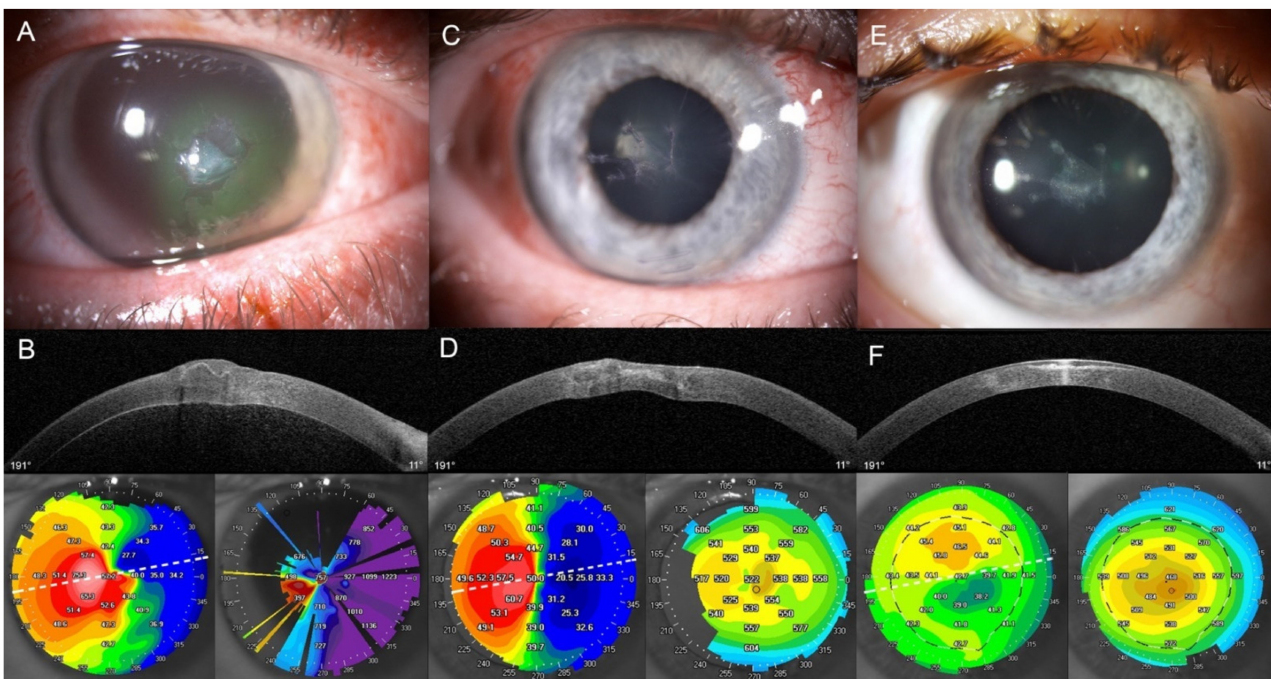
Figure 2. Disorganized central laceration in stromal mush, caused by high-speed projectile (stone) while riding a motorcycle, on a 43-year-old man. Multimodal imaging of the corneal wound. [( A , C , E ): Slit lamp images (Topcon). ( B , D , F ): Anterior segment OCT (AS-OCT), topography and pachymetry map (SS-OCT CASIA 2, Tomey) images]. ( A , B ) Baseline examination showing a central wound of 2.75 mm in diameter in zone 1 (OTC group), with epithelial defect, stromal edema and loss of transparency due to a mush under the retracted Bowman’s membrane (BM) with inferonasal hinge. A second laceration was close to the inferior limbus. Anterior chamber was normal. B-scan showed the disorganized anterior stroma with the BM flap (waved hyperreflective line). There were 12.2 diopters of corneal astigmatism, with major artifacts (suboptimal segmentations not improvable of software) on topography (white dashed line indicates B-scan axis) and pachymetry maps. Maximum lamellar depth was 47% of total corneal thickness. Preoperative far visual acuity (VA) was 20/2000 (2.0 logarithm of the minimal angle resolution (logMAR)). ( C , D ) Postoperative result at Day 10, showing four central light-purple threads of polyglactin 910 (or V10-0) which spared the visual axis and stretched the BM flap, and three peripheral V10-0 threads which treated spiroid paralimbic scalp. There was a very significant improvement of central corneal transparency. B-scan showed progressive reorganization of the anterior stroma with a BM flap flattened thanks to suture-induced tension. Artifacts were reduced on topography with transient suture-induced astigmatism. Initial post-traumatic stromal mush reduced central corneal thickness. ( E , F ) Mid-term result at Month 2, the wound healed with a mild central opacity corresponding to the interface of wounded BM. No more threads were present. A mild loss of transparency was visible at the entry and exit points of the threads path. Comparative B-scan showed longitudinal anterior stromal hyperreflectivity corresponding to the wounded BM, which was flattened thanks to surgery, but thickened with reorganized keratocytes. Residual astigmatism was 1.9 diopters. Pachymetry map was homogeneous and central corneal thickness was reduced in the area of the initial wound (central 3 mm). Postoperative far VA was 20/32 (0.2 logMAR) and near VA was Jaeger 5 (0.4